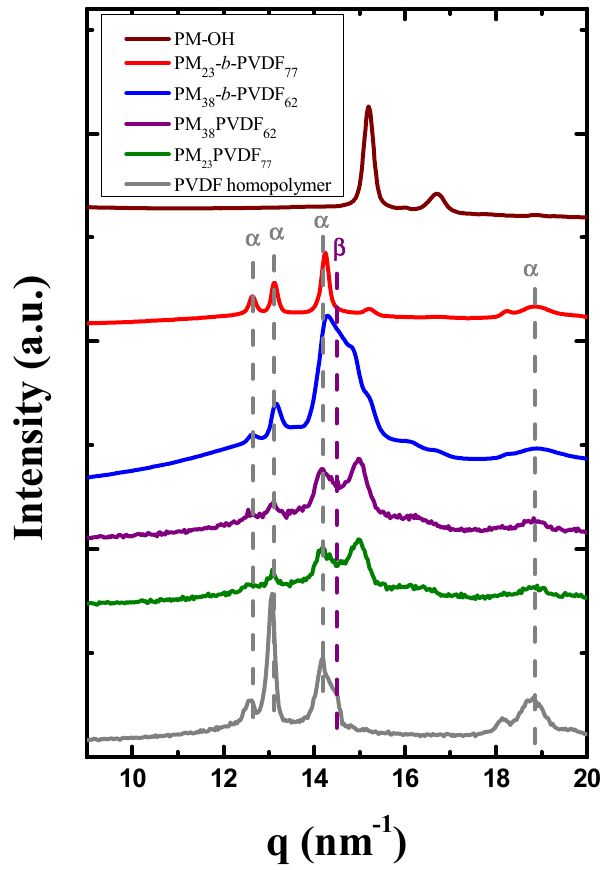
Figure 7. WAXS diffraction patterns of PM-OH, PVDF homopolymer, both blends, and both block copolymers at room temperature after a crystallization process at 1 °C/min. The grey dashed lines indicate the peaks associated to the α -phase, and the purple dashed line indicates the peak of the β -phase.